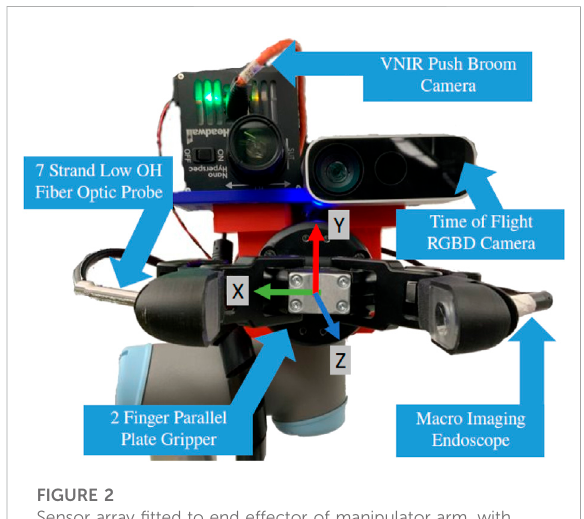
FIGURE 2 Sensor array fi tted to end effector of manipulator arm, with sensory systems for both scene and in-hand object sensing. NB : Z -axis is perpendicular, coming out of the